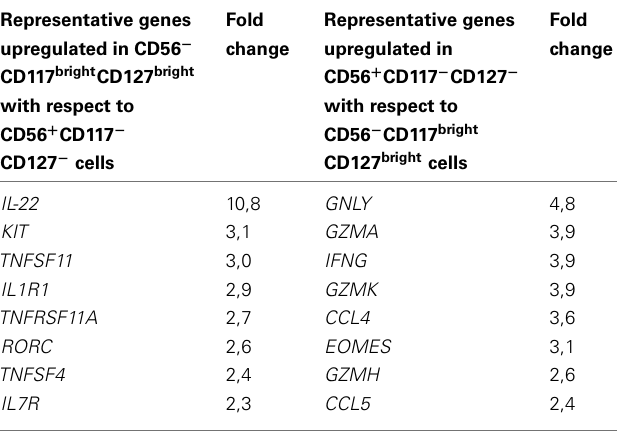
Table 1 | Example of genes upregulated at least twofold in the reciprocal comparison between CD56 − CD117 bright CD127 bright and CD56 + CD117 − CD127 −